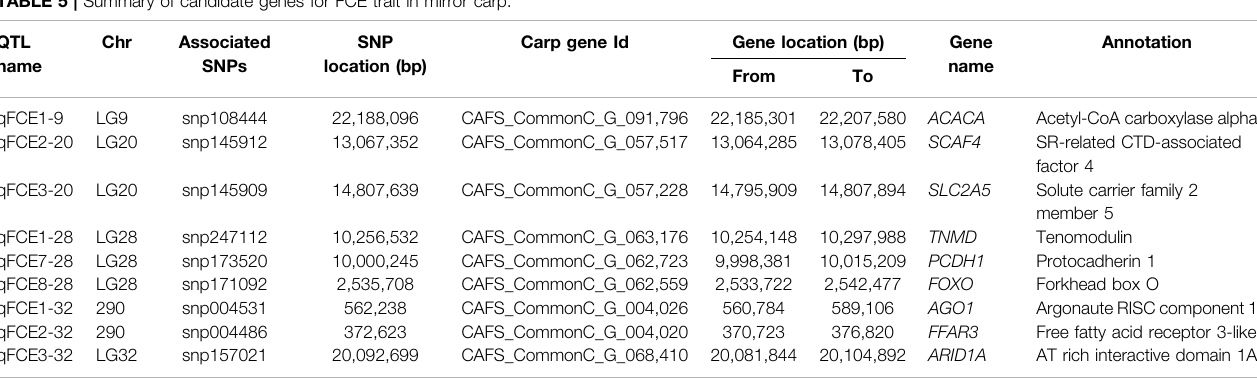
TABLE 5 | Summary of candidate genes for FCE trait in mirror